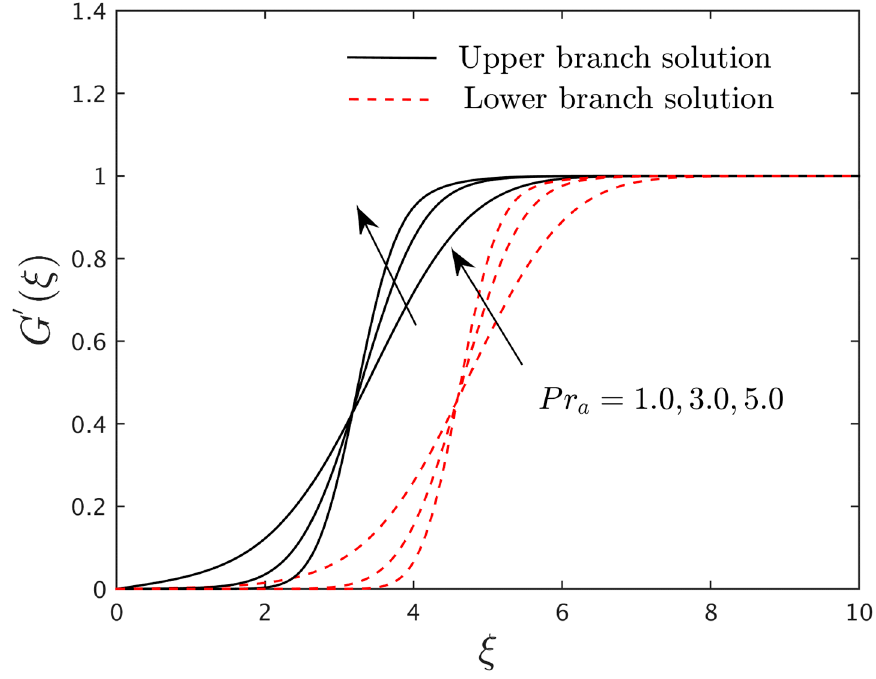
( ) ' G ξ for the numerous values of Pr a when